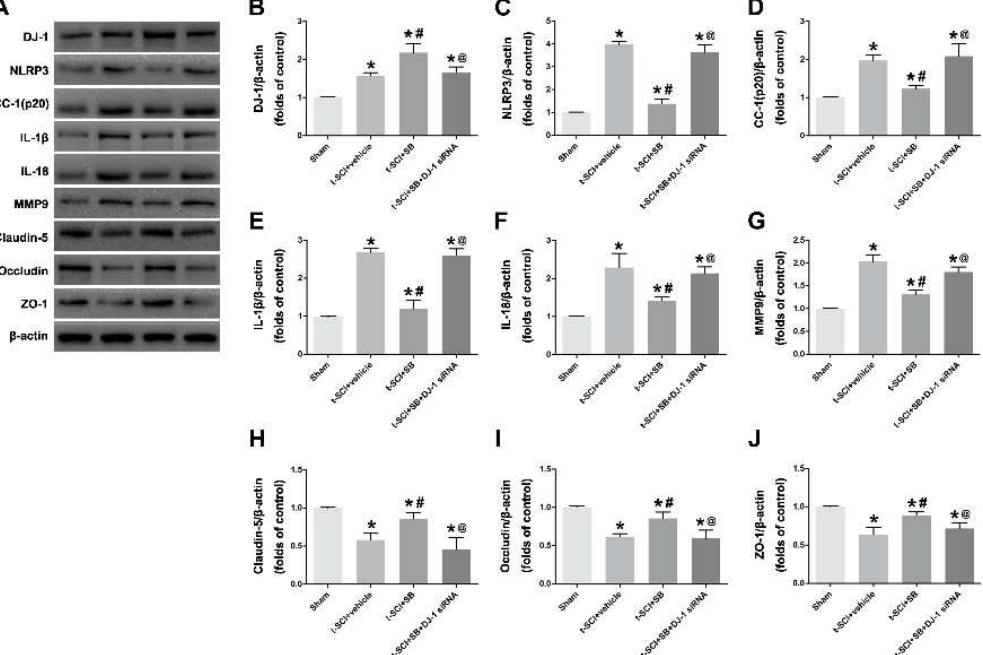
Figure 4. SB increased the neuroprotective effects of DJ-1 on inhibiting NLRP3 inflammasome activation and alleviating BCSB disruption. ( A – G ): Representative Western blotting images and quantitative analyses of DJ-1, NLRP3, cleaved caspase 1 (cc-1), IL-1 β , IL-18 and MMP9 expression at 24 h post-injury. ( H – J ): Representative Western blotting images and quantitative analyses of tight junction proteins including Claudin-5, Occludin and ZO-1 at 24 h post-injury. n = 6 for each group. * p < 0.05 vs. sham ; # p < 0.05 vs. t-SCI + vehicle ; @ p < 0.05 vs. t-SCI + SB .